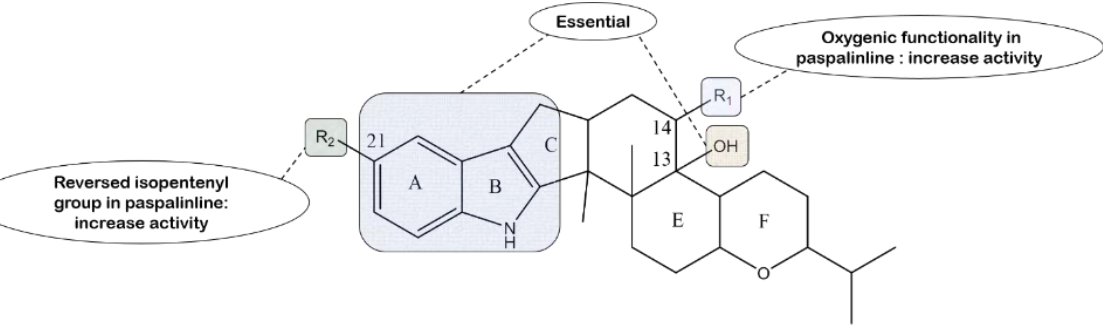
Figure 21. Structure – activity (anti-insect) relationship of paxilline indole diterpenes.